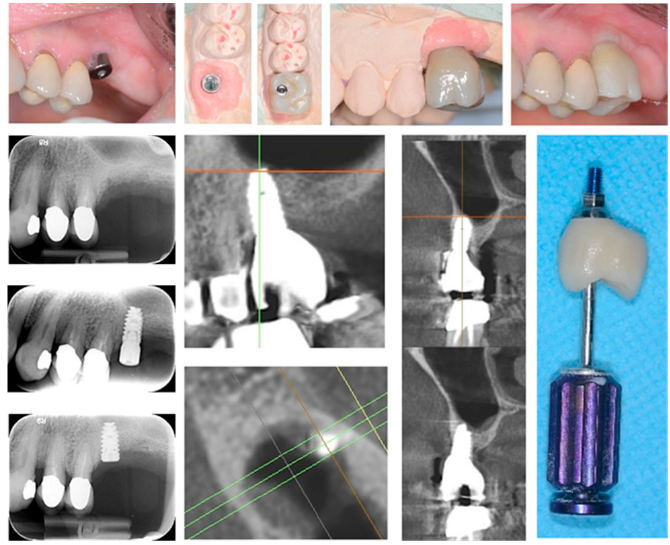
Figure 4. Implant-supported single tooth restoration in atrophic posterior maxilla with all of the pre- and post-surgical phases until final screw-retained prosthetic rehabilitation.